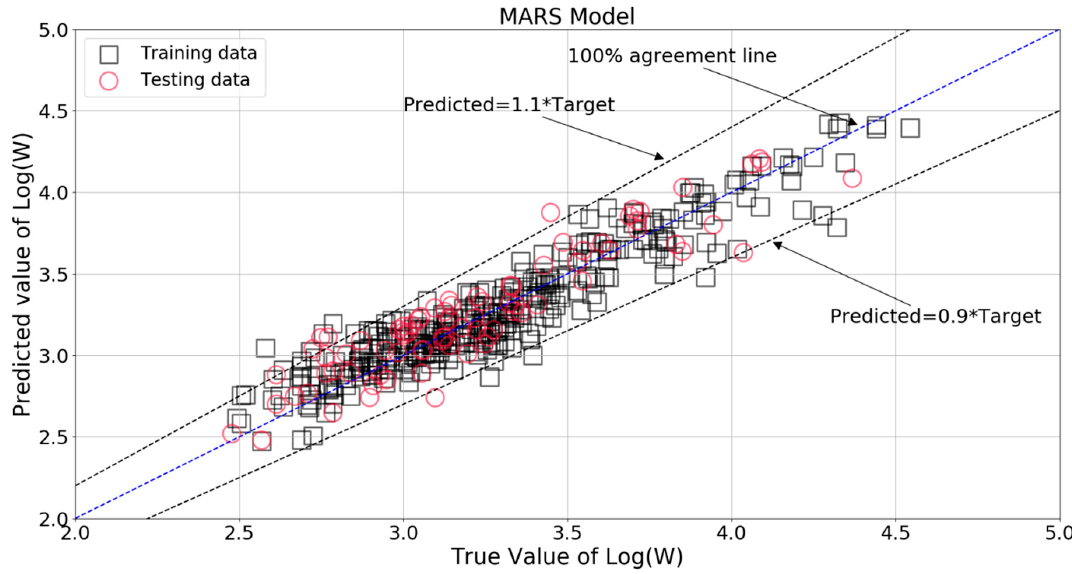
Figure 30. Comparison between the target and MARS model predicted Log(W).